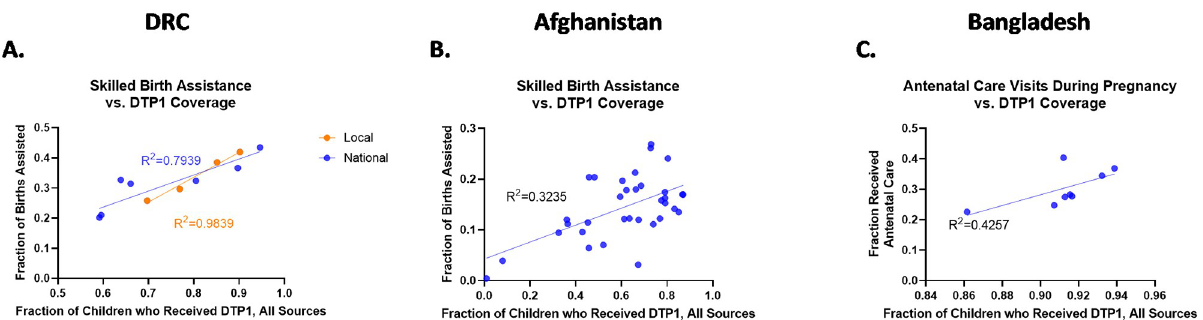
Fig 3. Linear regression between DTP1 and birth assistance in DRC (A), Afghanistan (B), and Bangladesh (C). Skilled birth assistance was considered as receiving assistance from a doctor, nurse, midwife, or healthcare worker. Linear associations were observed in DRC (A), Afghanistan (B) and Bangladesh (C) for skilled birth assistance (R 2 = 0.79, 0.32, and 0.43